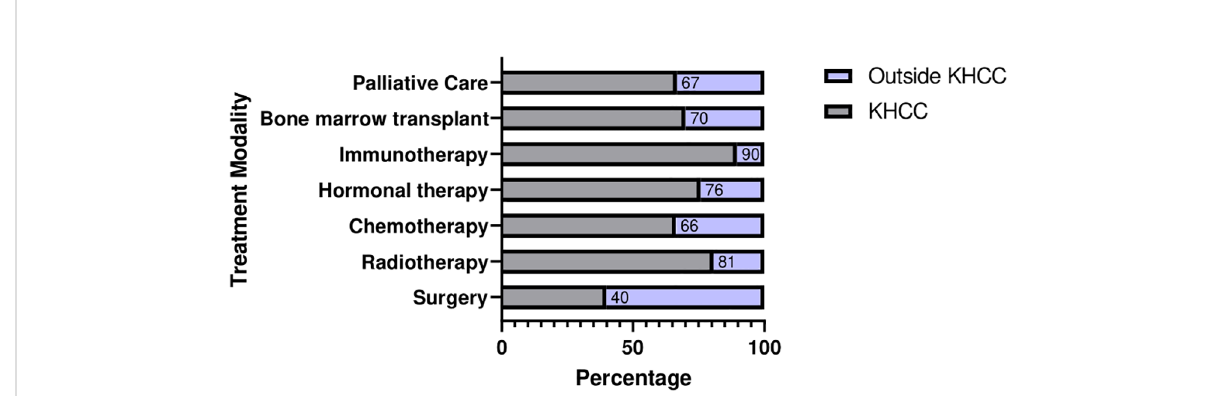
FIGURE 5 Comparison of treatment options offered to patients before and after referral to